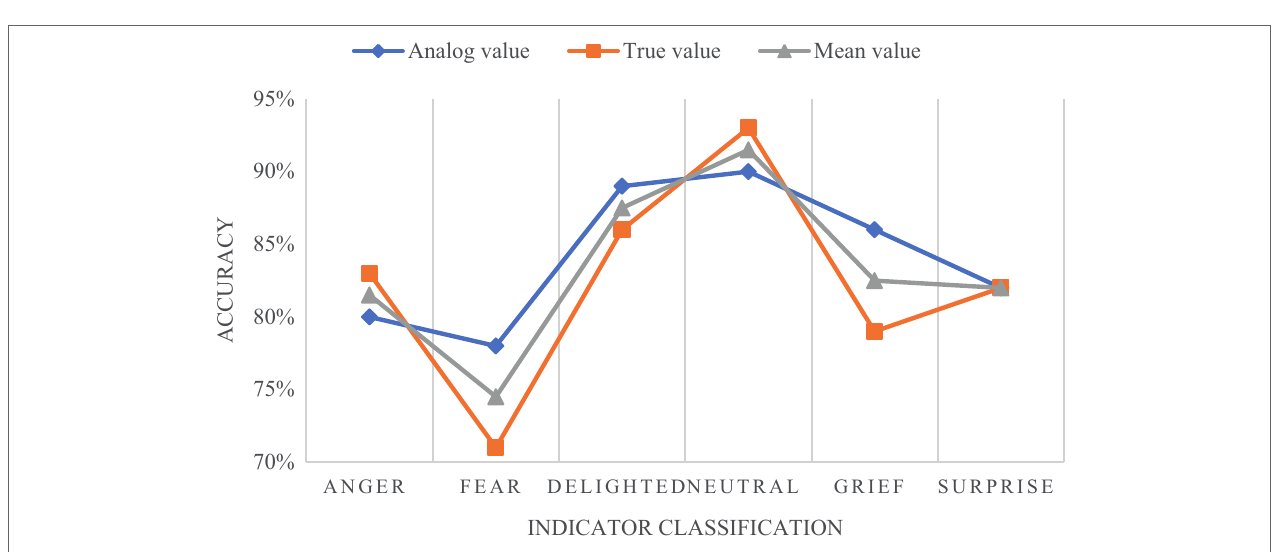
FIGURE 3 | Comparison results of emotion test.